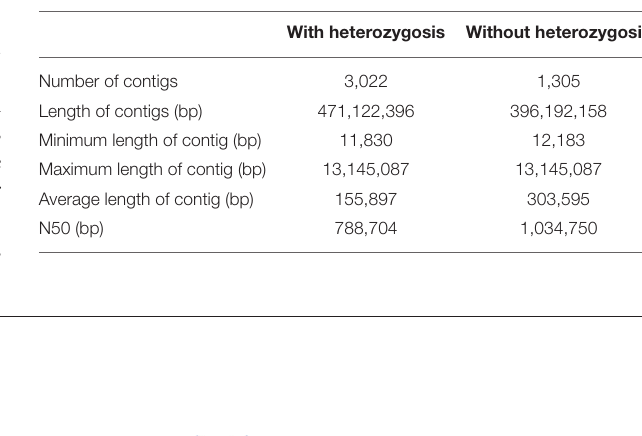
TABLE 1 | Statistics of mango genome assembly.